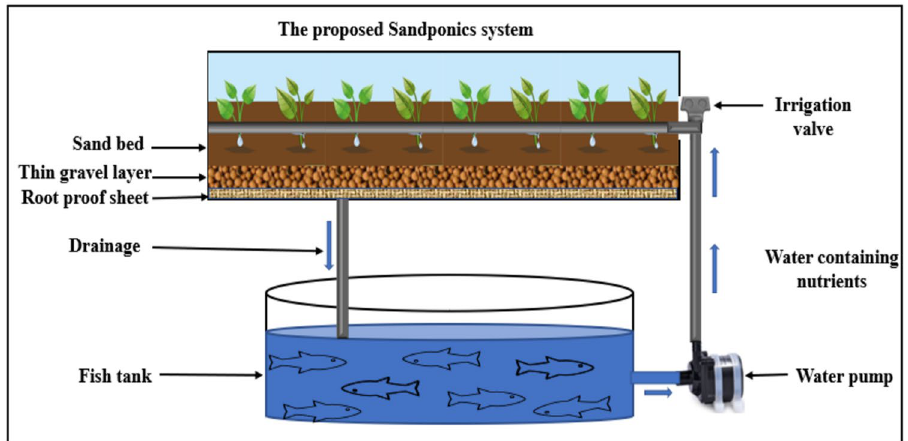
Figure 1. Schematic design of the experimental layout.